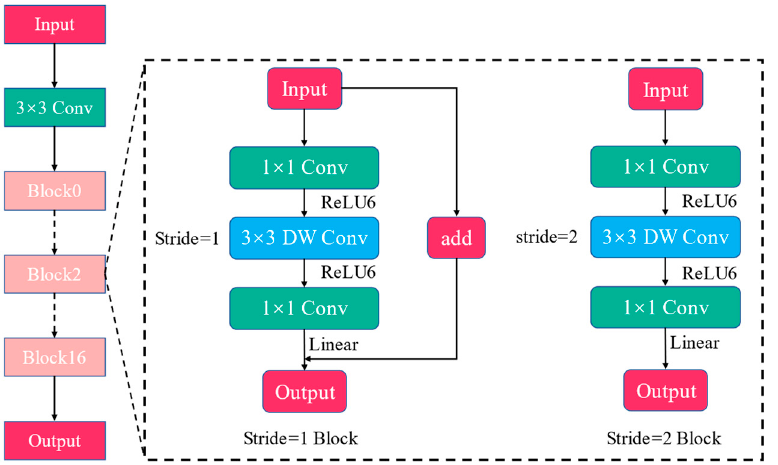
Figure 3. The network structure of MobileNetv2. Two different classes of blocks exist. The first is a residual block with a stride of 1. Another block has a stride of 2 for